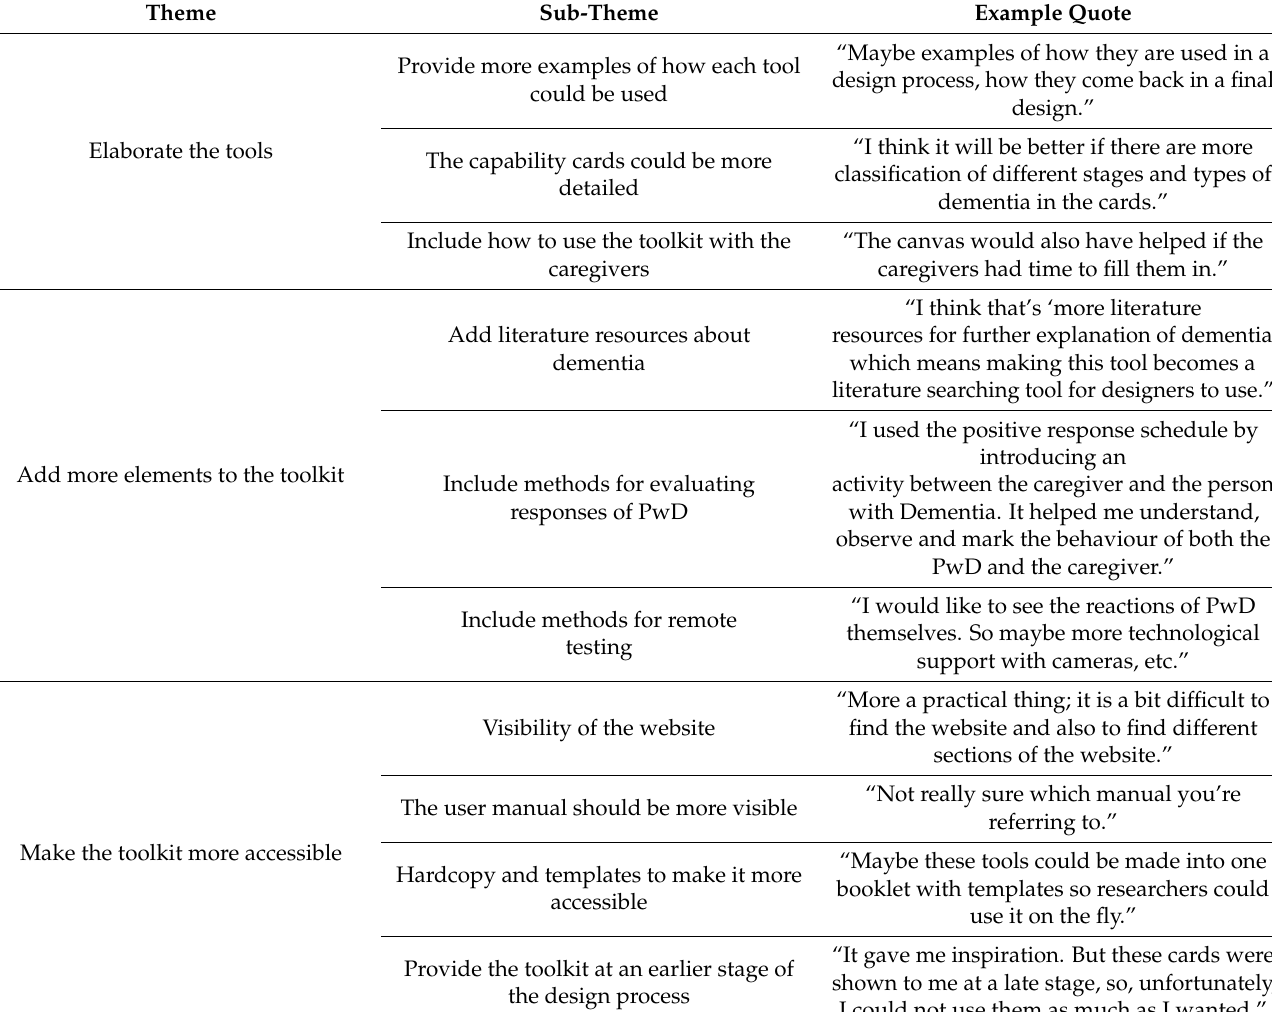
Table 2. Themes and sub-themes on the desired improvement of the “Know-me” toolkit with example quotes.